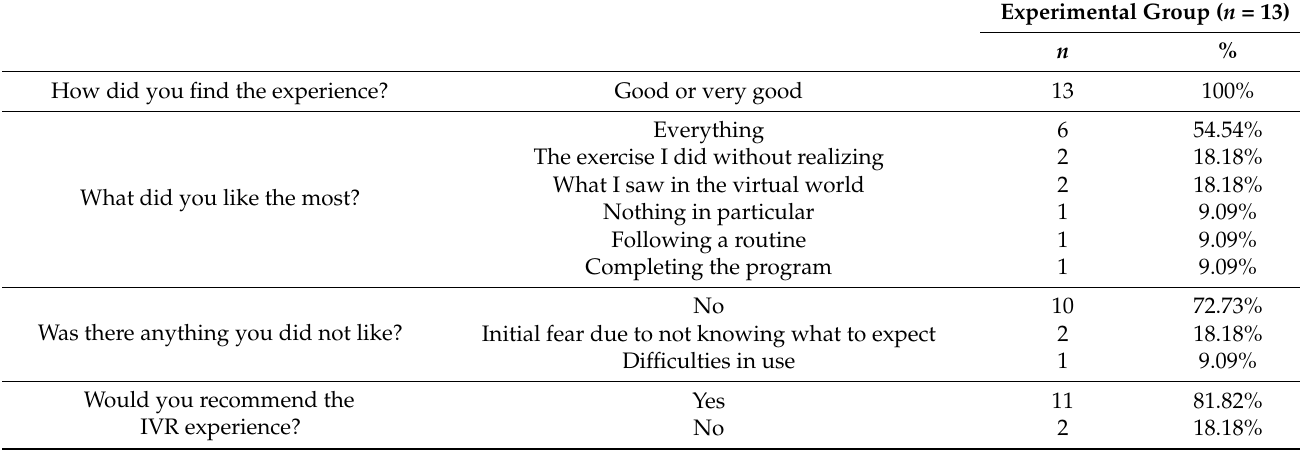
Table 7. Ad hoc satisfaction questionnaire and responses from